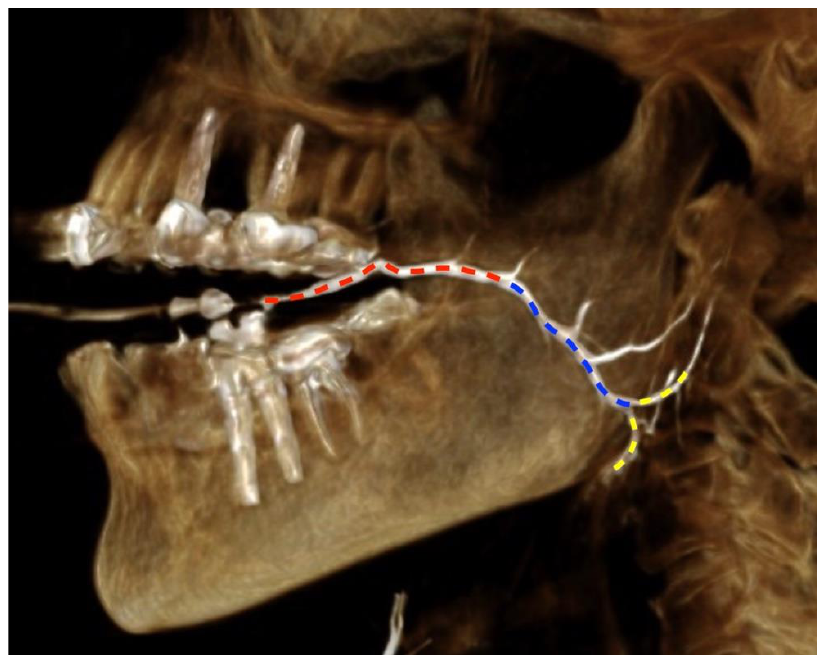
Figure 3. Parotid duct distances measurements. red: distance between papilla and curvature, blue: distance between curvature and hilus, yellow: bifurcation after duct hilus.